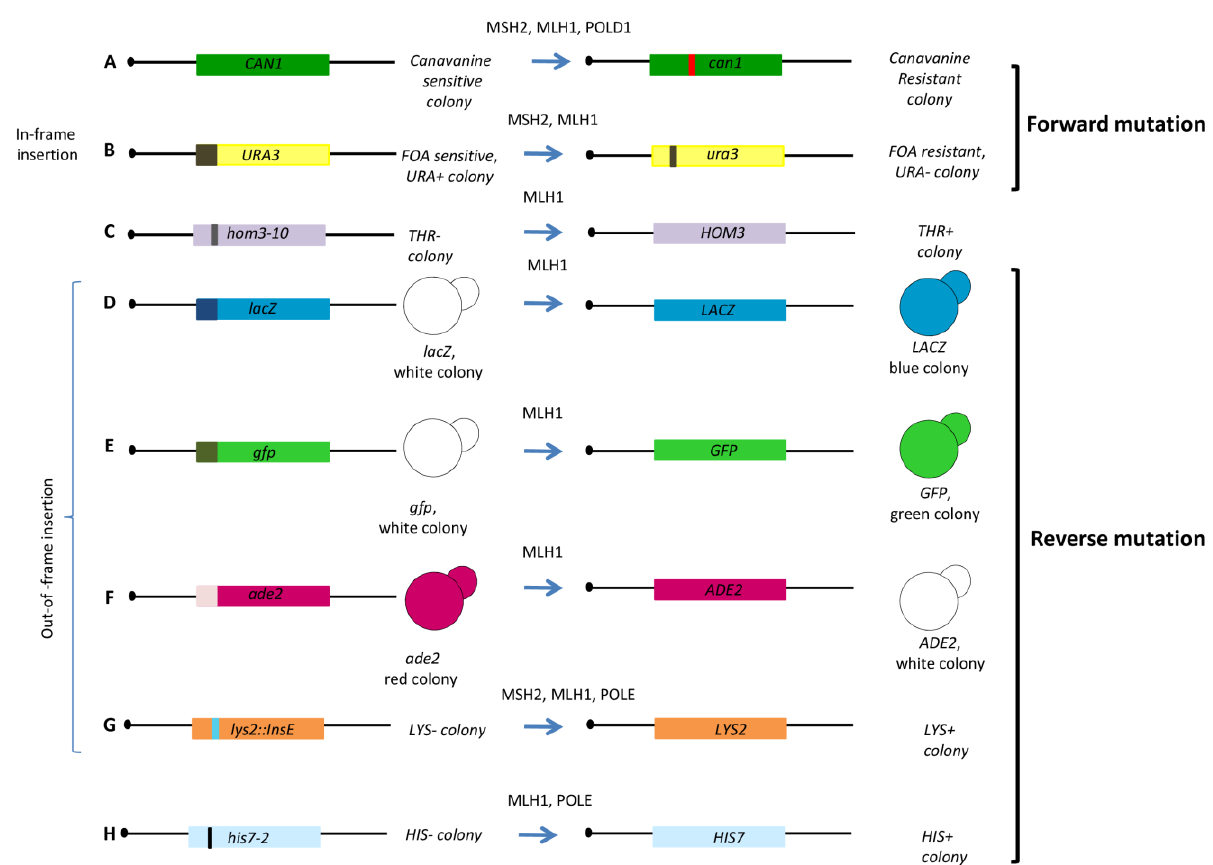
FIGURE 3: Schematic representation of the yeast functional assays for MMR genes . Forward mutation frequency/rate is evaluated by scor- ing the number of colonies becoming resistant to (A) Canavanine ( CAN1 to can1 ) or (B) 5-fluoroorotic acid (5-FOA, URA3 to ura3 ). Reverse mutation is assessed by counting the number of colonies becoming able to grow in selective medium lacking threonine (C) (THR+; hom3-10 to HOM3 ), (D) colonies becoming blue ( lacZ to LACZ ), (E) colonies becoming green ( gfp to GFP ), (F) colonies becoming white in medium lack- ing adenine (ADE+; ade2 to ADE2 ), (G) colonies becoming able to grow in medium lacking lysine (LYS+; lys2 to LYS2 ) and (H) colonies becom- ing able to grow in medium lacking histidine (HIS+, hys7-2 to HIS7 ). The URA3 gene used for forward reversion (B) contains an in-frame inser- tion of several nucleotides, therefore the gene is WT. Constructs of D, E, F and G contain out-of-frame insertion of several nucleotides, there- fore the gene is mutated. Constructs of C and H contain a point mutation. Above the arrow are given the names of the human proteins stud- ied with the OPEN ACCESS | www.microbialcell.com